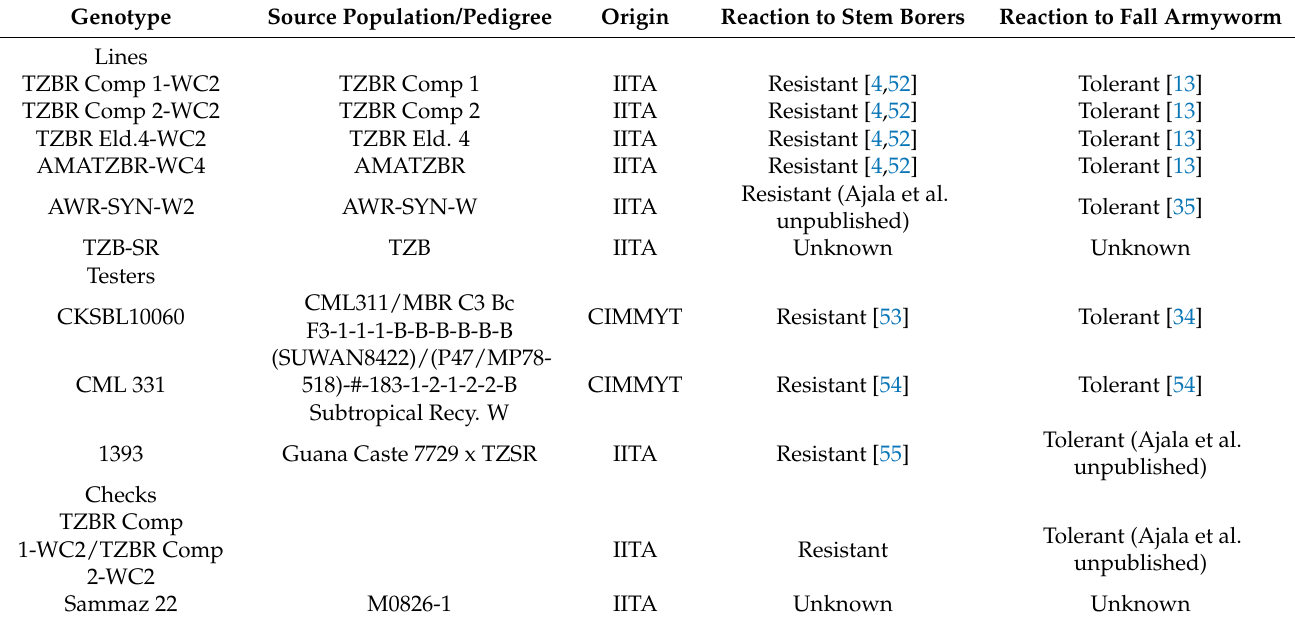
Table 1. Source populations and stress adaptation(s) for the maize genotypes used for the